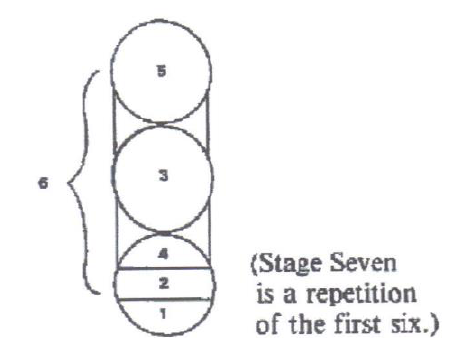
Figure 7: Ego State Development (Levin 1982 p. 130)